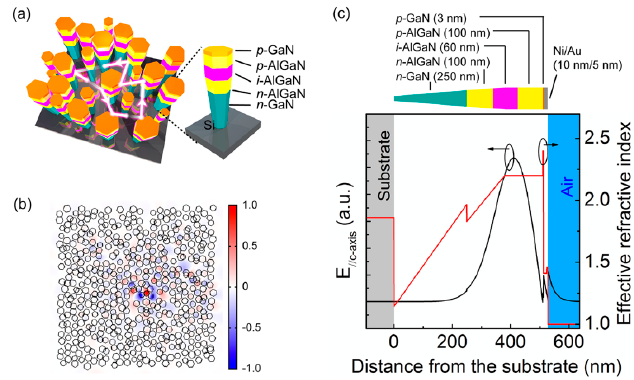
Figure 11. ( a ) Schematic of light localization effect in randomly arranged AlGaN nanowire structures. ( b ) In-plane electrical field distribution for a TM polarized light at 240 nm. ( c ) Out-of-plane electrical field profile and the effective refractive index variation along the nanowire growth direction ( c -axis) [94].